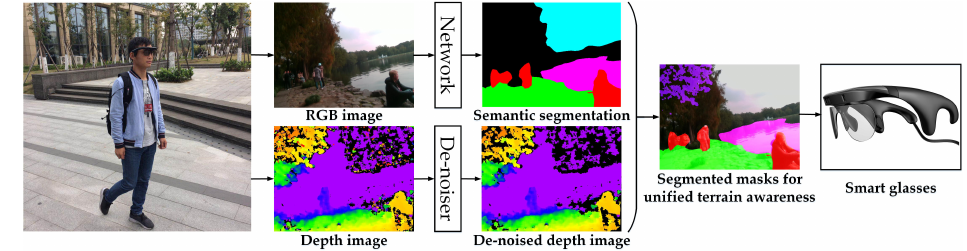
Figure 2. Overview of the navigation assistance